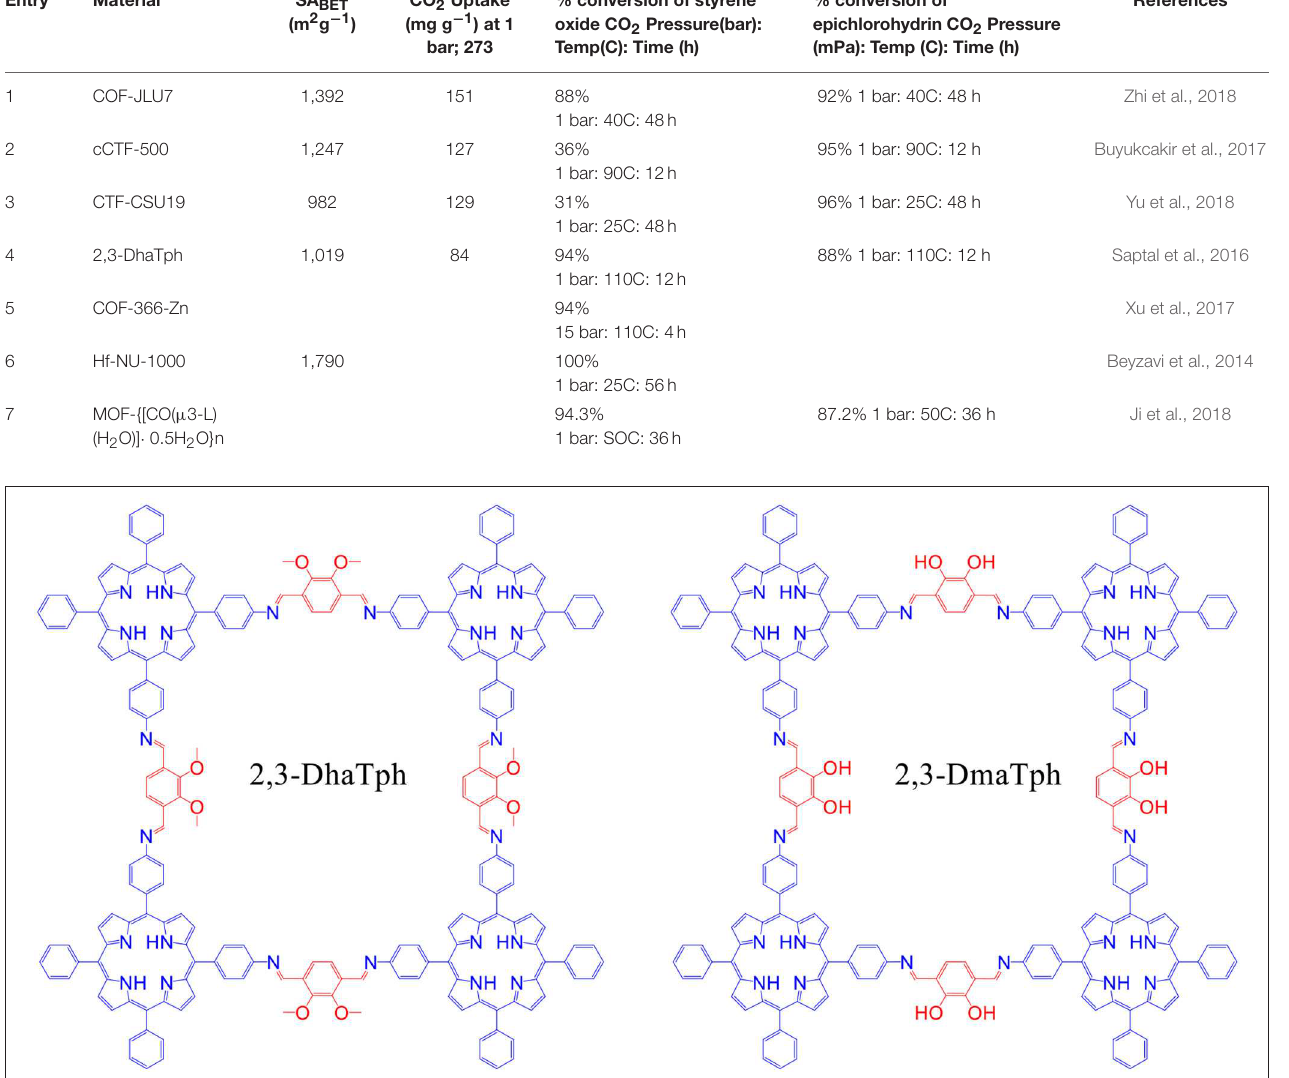
FIGURE 20 | Structure of 2,3-DhaTph and 2,3-DmaTph. Reprinted with Permission © 2016 The Royal Society of Chemistry.